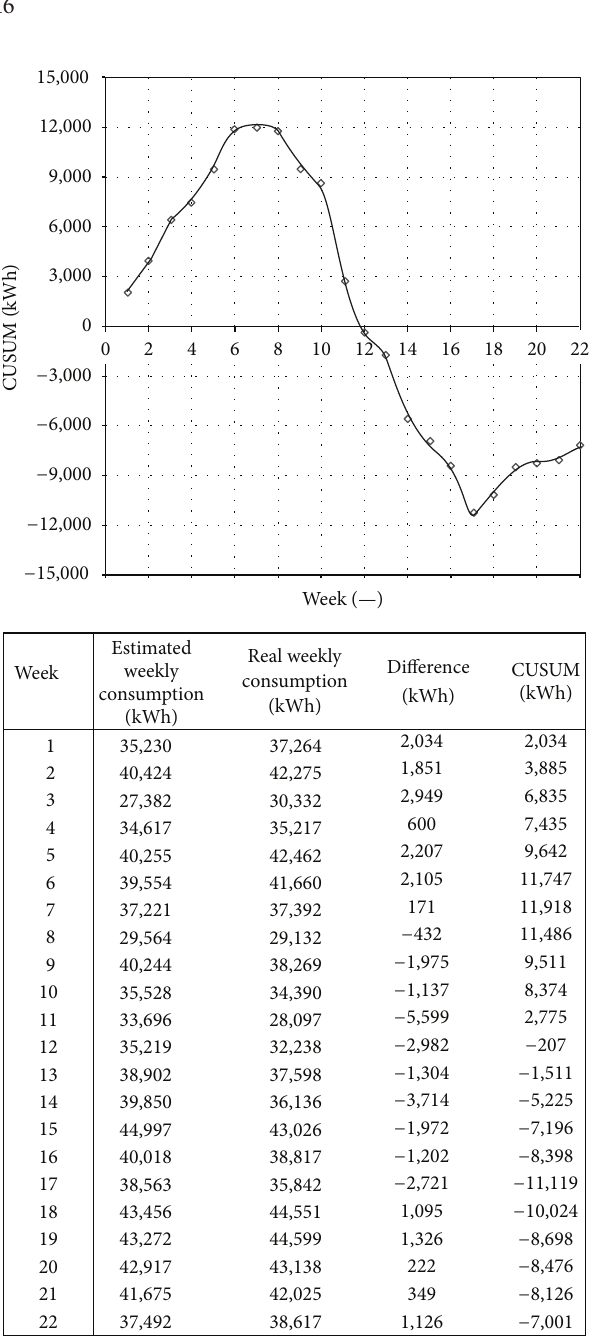
Figure 7: Example of CUSUM application in wood